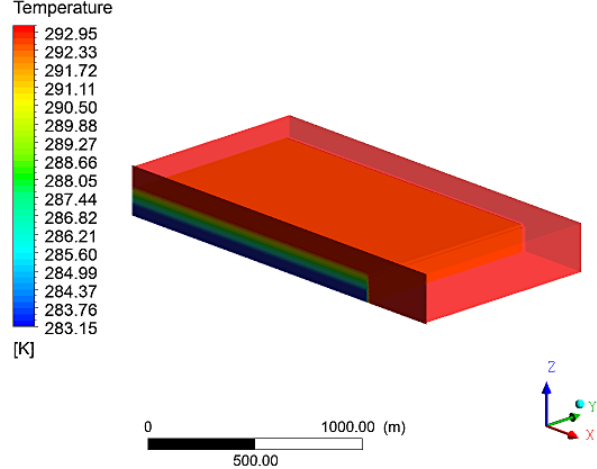
Figure 10. Initial condition for internal wave simulation shown in the model temperature field (in kelvin). Domain length ( x ) is 2km; domain width ( y ) is 1km; domain depth ( z ) is 250m. Model hori- zontal resolution is 10m and vertical resolution 2m, with increased vertical resolution in the